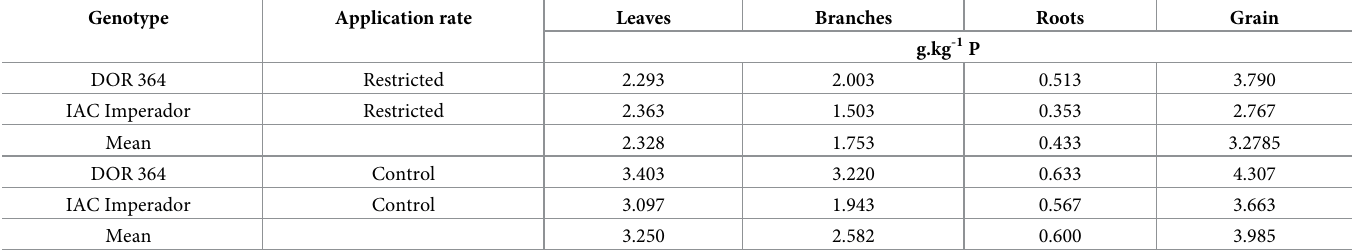
Table 3. Mean P concentration (g.kg -1 ) in the leaves, branches, roots, and grains of the IAC Imperador and DOR 364 common bean genotypes grown hydroponi- cally under a restrictive phosphorus condition and under a control condition. Genotype